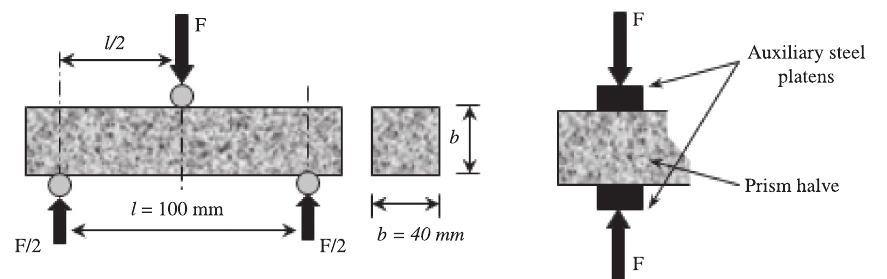
Figure 2. Three-point bending test and uniaxial compression.